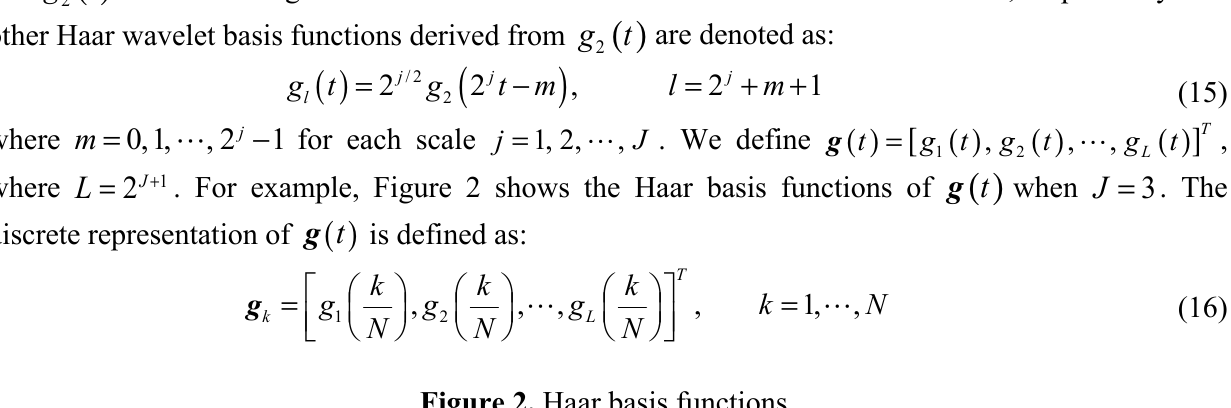
Figure 2. Haar basis